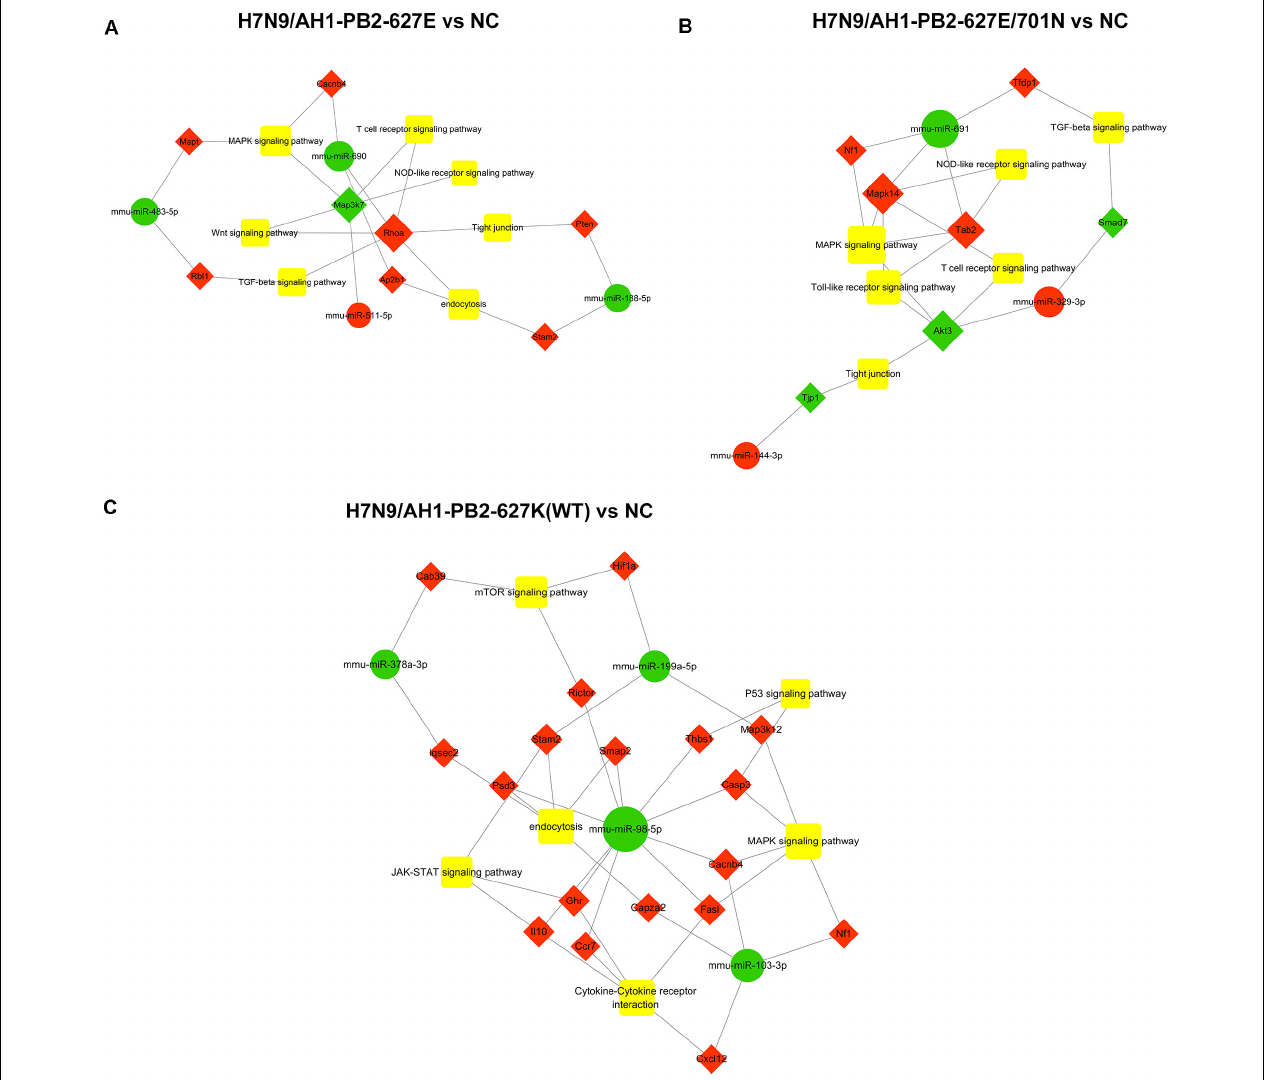
FIGURE 8 | Global analysis of specific differential expressed miRNAs in mouse lung infected with H7N9 and its mutant influenza viruses compared with negative control group (NC). miRNA-mRNA interaction network in three different infected groups was built according to the specific miRNAs and their oppositely expressed genes. Green circle indicates miRNAs while red diamond represent the corresponding target genes. The relationship between miRNAs and genes is connected by gray lines. The larger the circle is, the greater the degree to which the miRNA or gene involved in the related pathway. (A) in H7N9/AH1-PB2-627E infected vs. NC group; (B) in H7N9/AH1-PB2-627E/701N infected vs. NC group; (C) in H7N9/AH1-PB2-627K(WT) infected vs. NC